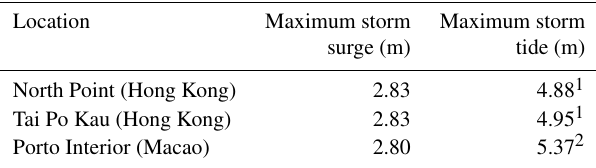
Table 5. The estimated maximum storm surges and maximum storm tides at North Point and Tai Po Kau in Hong Kong and Porto Interior in Macao during the passage of Typhoon 1874. Location Maximum storm Maximum storm surge (m) tide (m) North Point (Hong Kong) 2.83 4.88 1 Tai Po Kau (Hong Kong) 2.83 4.95 1 Porto Interior